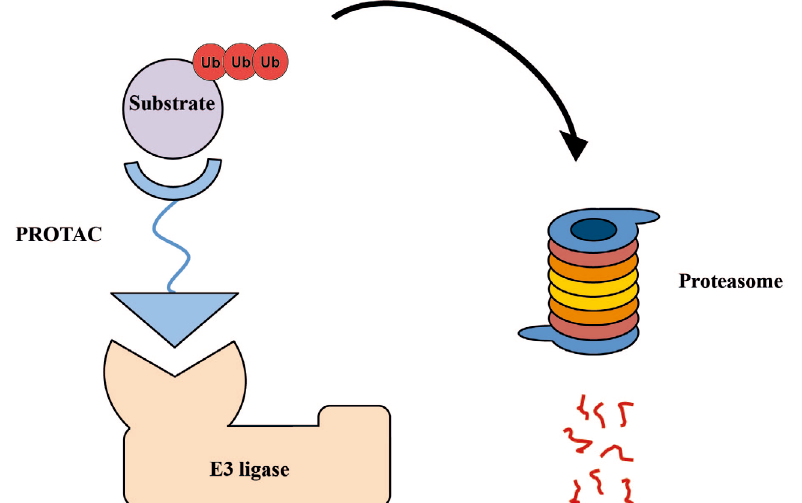
Figure 1. Schematic representation of PROTAC molecule acting to induce ubiquitination and subsequent proteasomal degradation of substrate POI (image adapted from [1] and modified). These small molecule degraders contain substrate-specific component, short linker, and E3-specific